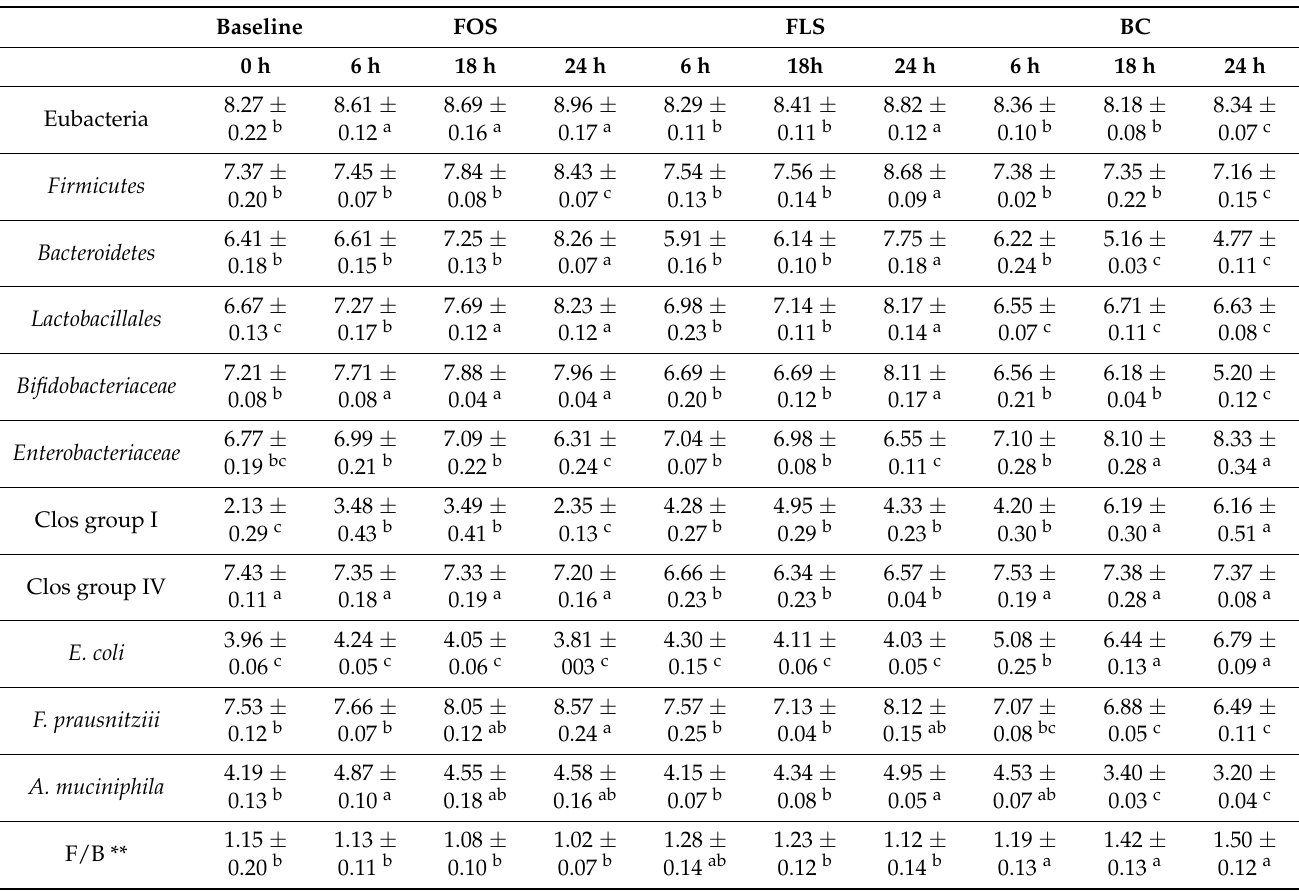
Table 1. Absolute quantification by qPCR and SYBR Green I chemistry expressed as means of sextuplicates and S.D. in Log 10 GCN/mL